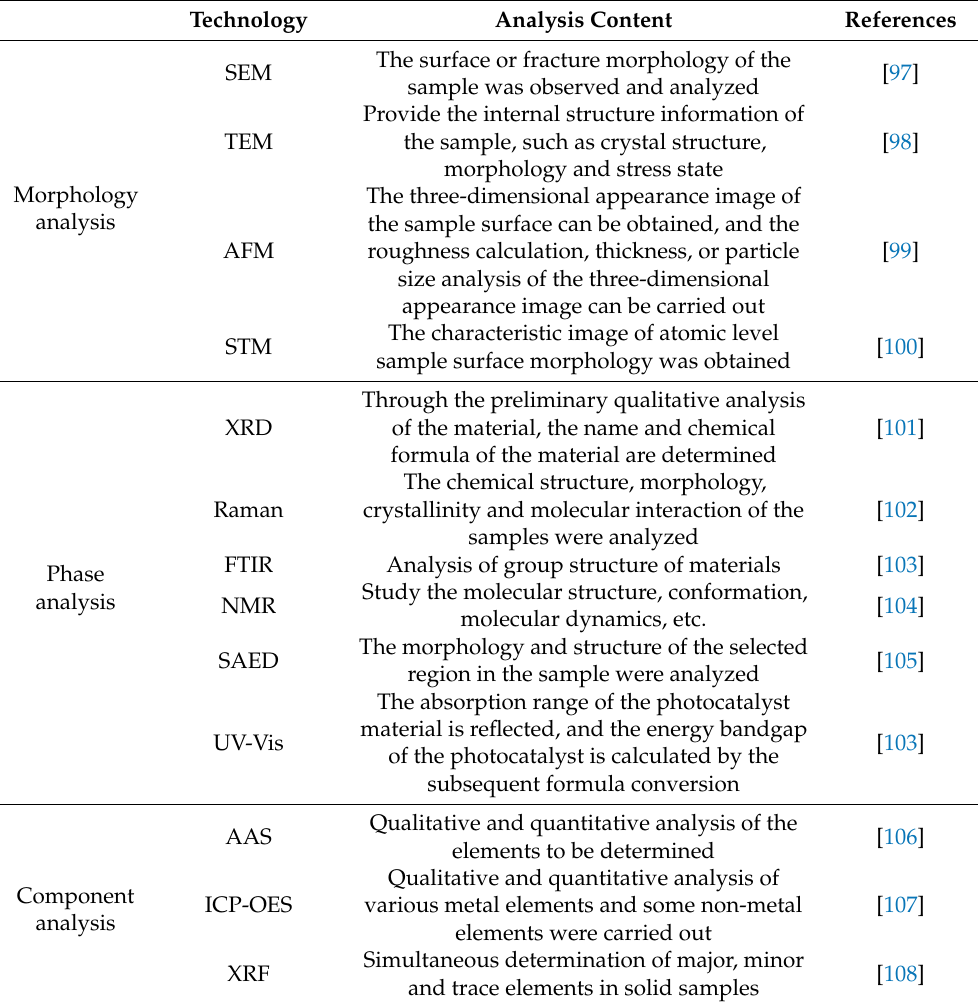
Table 1. Characterization methods of morphology, phase and composition analysis of carbon nitride- based photocatalytic